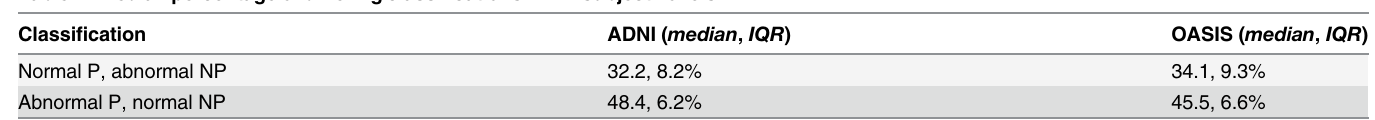
Table 2. Median percentage of differing classifications in AD subject voxels.